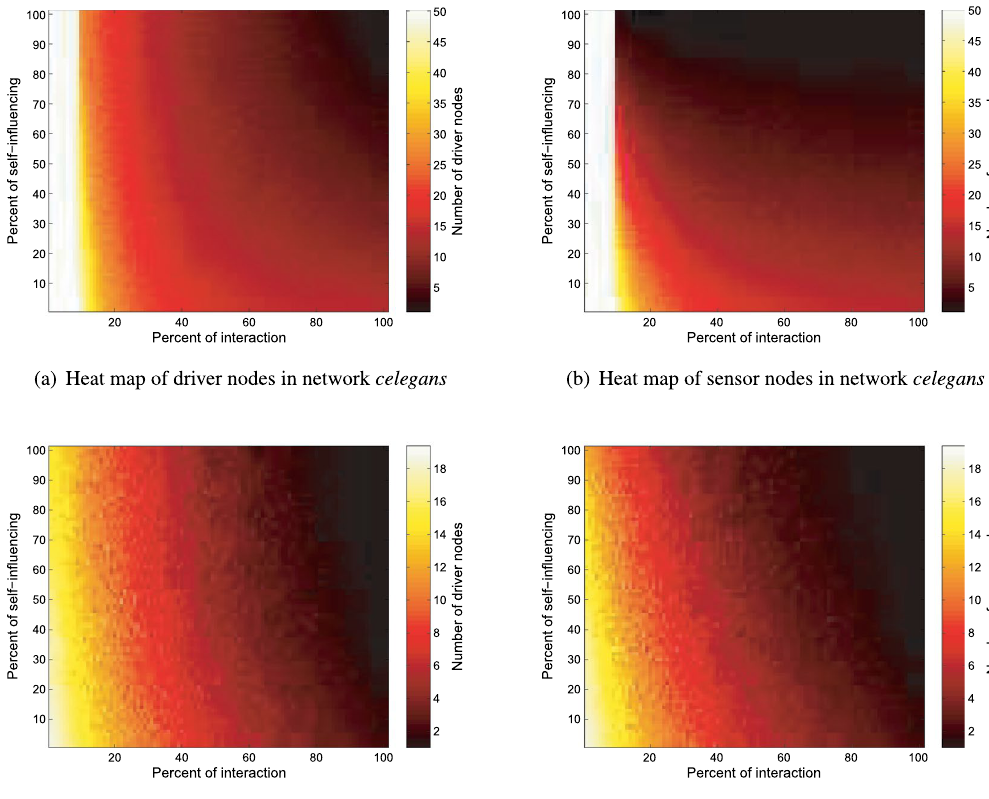
Figure 10. Number of driver and sensor nodes as a function of the presence of self-influence and interactions. The heat map clearly shows that with the increase in self-influencing and interaction type edges the number of driver and sensor nodes decreased progressively. The white bars in heat maps of celegans network are caused by the initial existence of 9% of interaction type